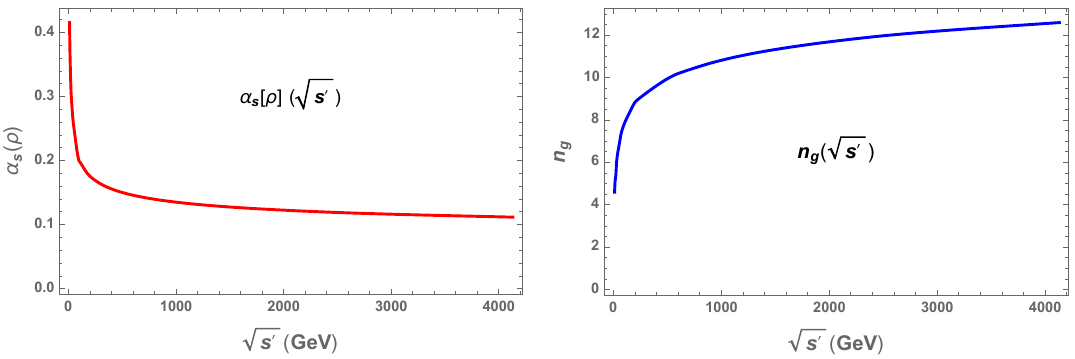
Figure 5 . The coupling constant (cid:11) s ( (cid:26) ) for the instanton process of the instantons size (cid:26) as the function of energy (left plot). The plot on the right shows the mean number of gluons, n g , in the (cid:12)nal